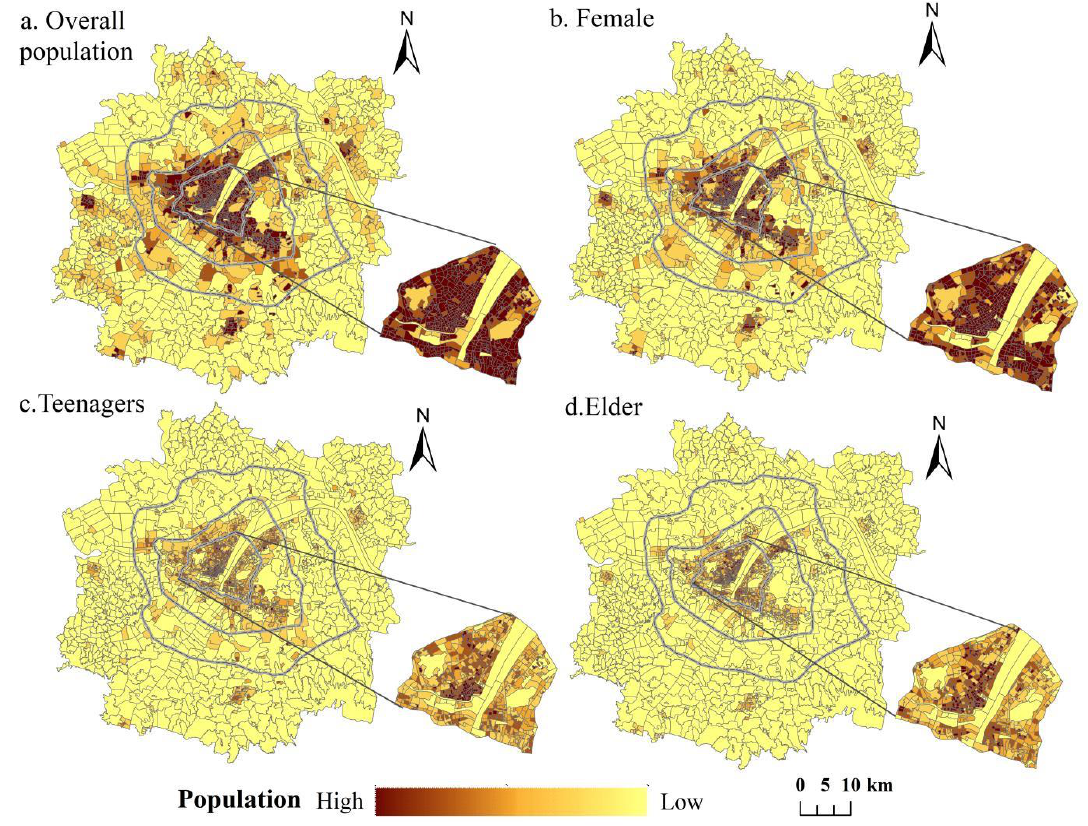
Figure 6. Spatial distribution of the residents’ supply of different groups.